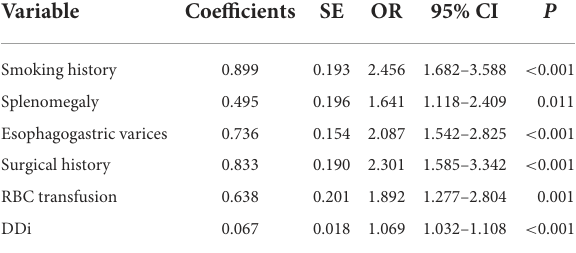
TABLE 4 Multivariate logistic regression analysis of the selected variables in the training